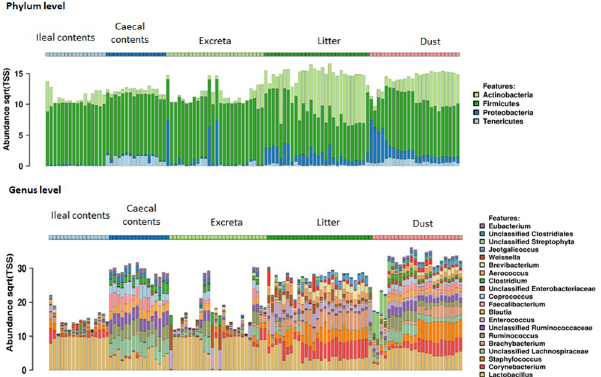
Fig 2. Abundance at the phylum level and top 20 most abundant genera for each sample type (caecal and ileal contents, dust, excreta and